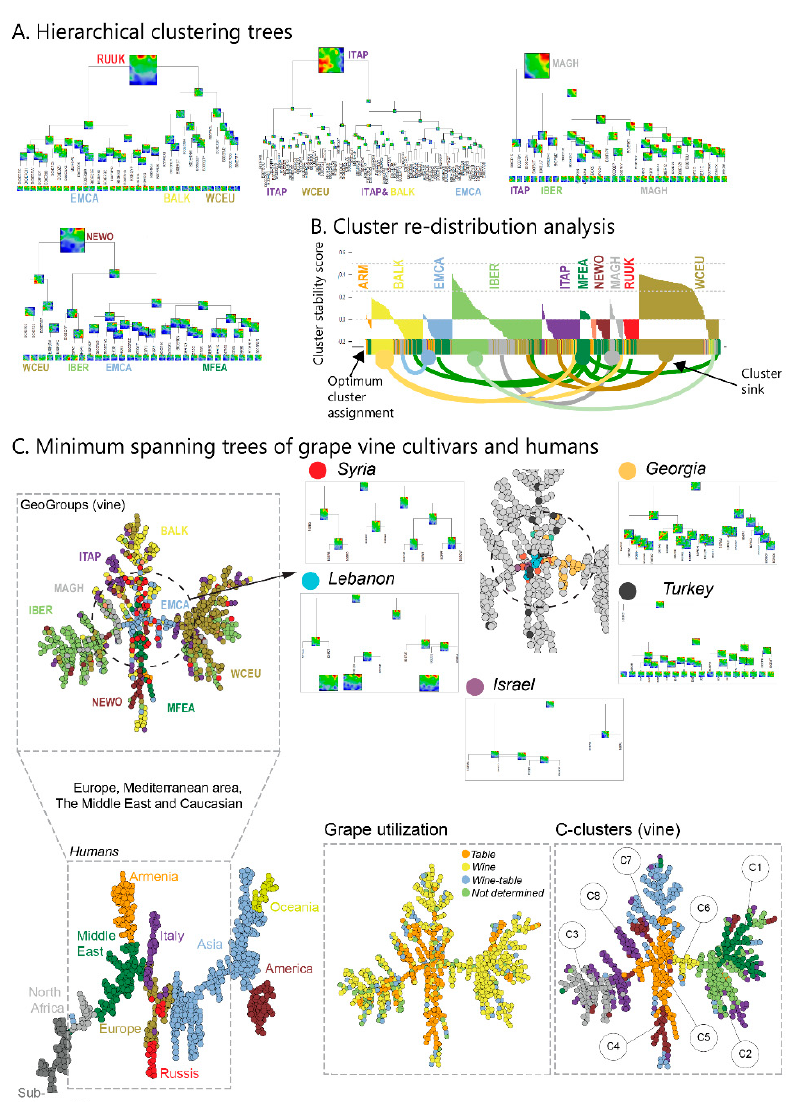
Figure 5. Genome diversity in and between the geographic regions: ( A ) Hierarchical clustering of vine cultivars from selected regions shows overlapping genomic properties. ( B ) The cluster stability plot (‘silhouette plot’) indicates intra- and inter-cluster similarities. The similarity score is positive for stable cluster-assignment of cultivars and negative, if a cultivar better matches into another cluster (the best-matching cluster for each cultivar is indicated by the colored bar below the silhouette plot). The arc-lines link unfavorable cluster assignments with the respective sink (best matching)-cluster. ( C ) The minimum spanning tree (MST) of the vine cultivars reveals four major leafs enriching IBER (and MAGH), BALK (and ITAP), WCEUR and MFEAS (and NEWO) grapes, respectively. The central ‘cross-road’ linking the four leafs enriches EMCA-cultivars. Particularly, cultivars from Lebanon, Israel and Syria locate within the ‘cross-road’ region (see an enlargement in the right part). Vines from Georgia form the trunk of the European part. Armenian and Turkish vines spread more widely along the MST. Re-coloring the MST according to grape utilization shows that table usage predominates along the vertical trunk of the MST (MCEU, EMCA) and along the MAGH-branch, while wine usage is found mainly for European grapes. Alternative clustering, as proposed previously (C-clusters) [11], better separates the clusters along the MST. The MST of human genomes of modern populations from Africa to Oceania taken from the Human Genome Project (HGP) shows a more linear arrangement (left part), reflecting different dissemination patterns. The dashed rectangle includes populations of the same geographic regions, as studied for the grapevine cultivars.